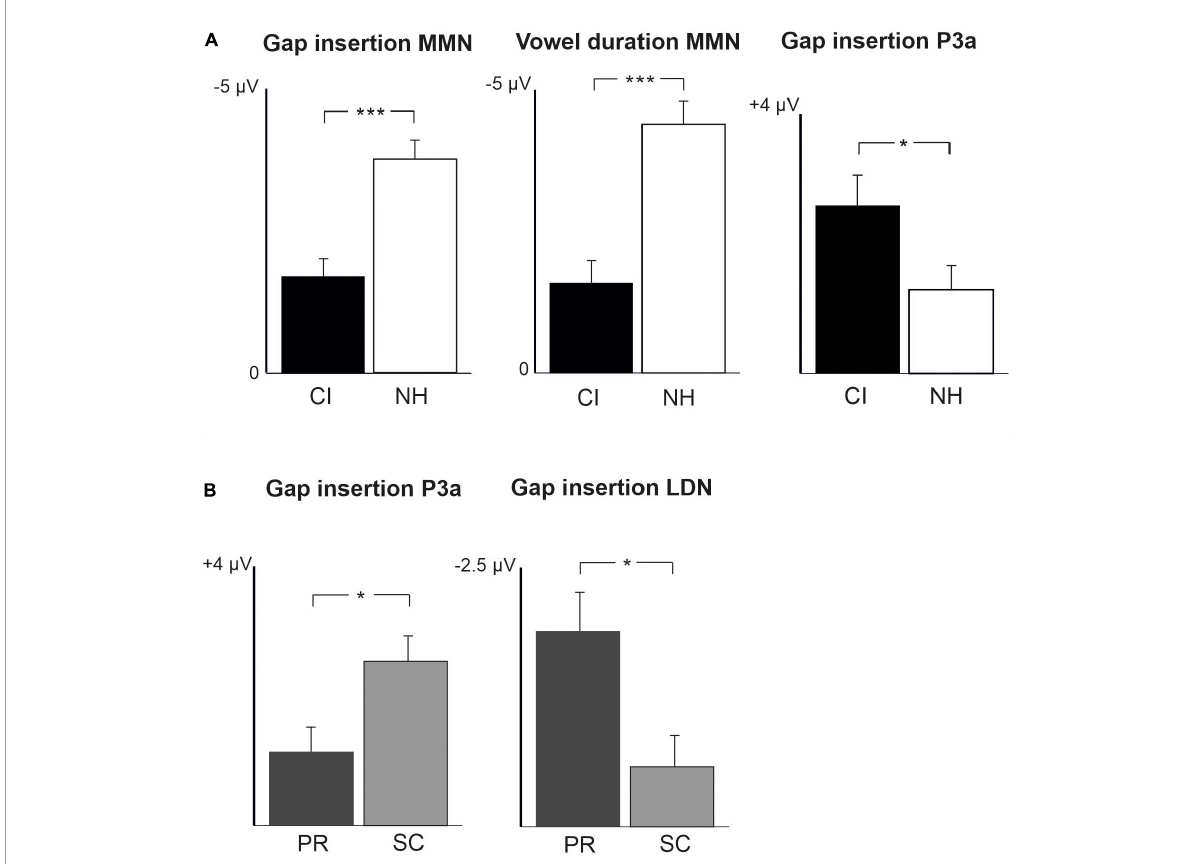
FIGURE2 Barcharts of significant main effects and interactions in Linear Mixed Modeling for the easy-to-detect change types of gap insertion and vowel duration. (A) CI vs. NH group main effects; (B) age (preschoolers vs. schoolchildren) main effects; MMN, mismatch negativity; CI, cochlear implant; NH, normal hearing. * p < 0.05, ** p < 0.01, *** p < 0.001. Note the different scales for different